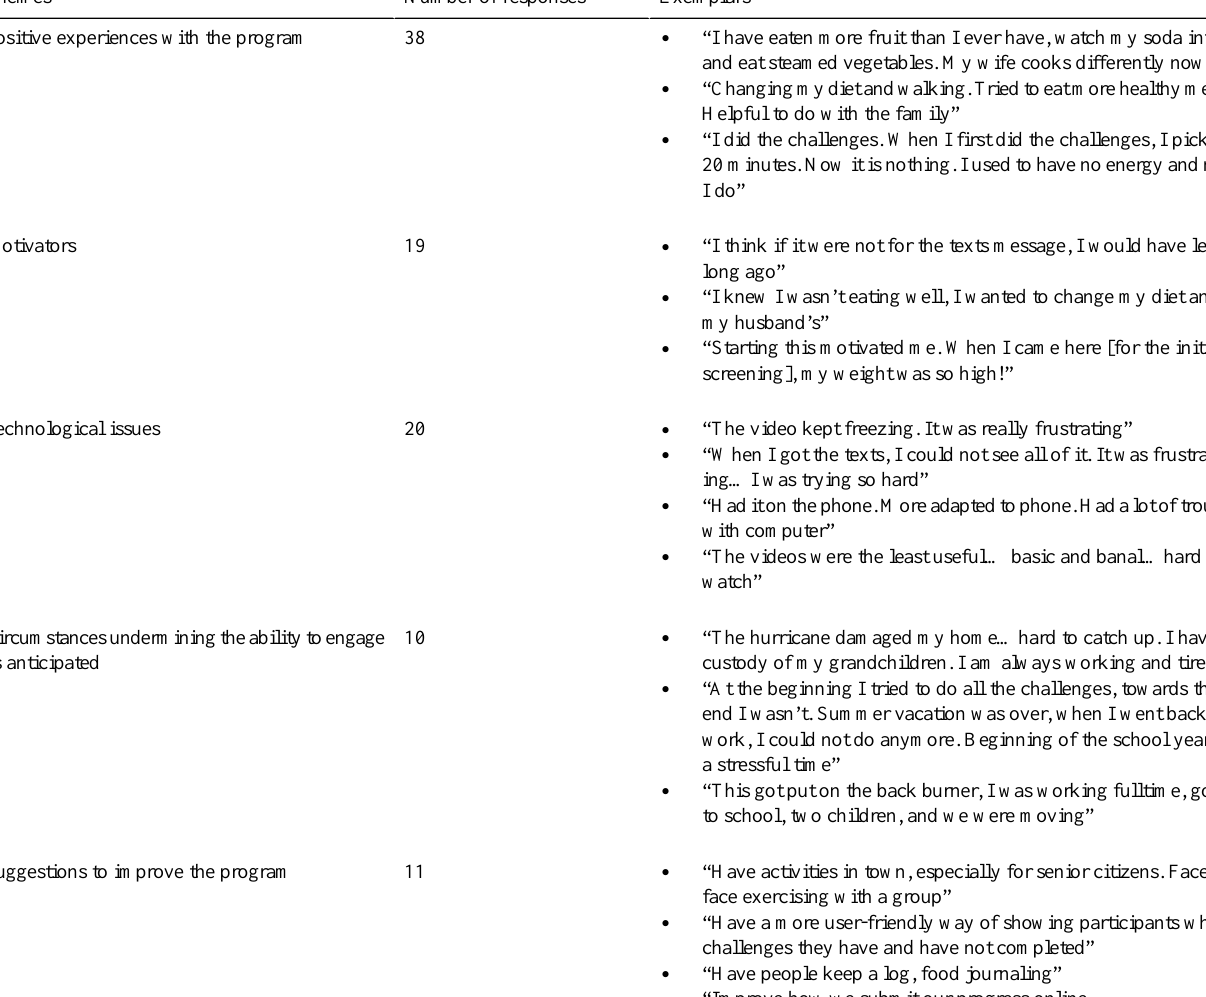
Table 7. Themes of participant interviews and exemplar statements (n=13).